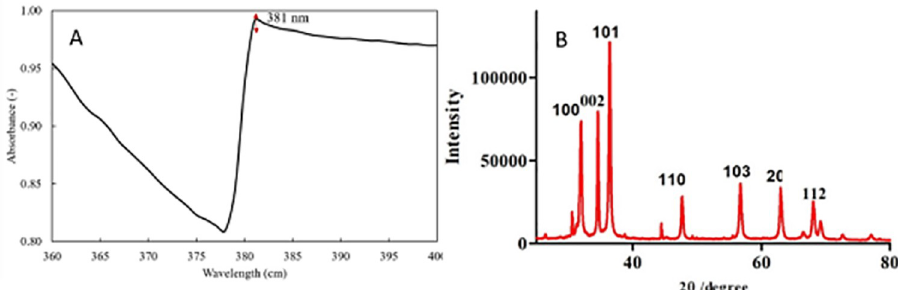
Fig 1. Absorption spectra using UV-Vis spectrophotometer (A) XRD pattern (B) of green synthesized ZnO NPs.